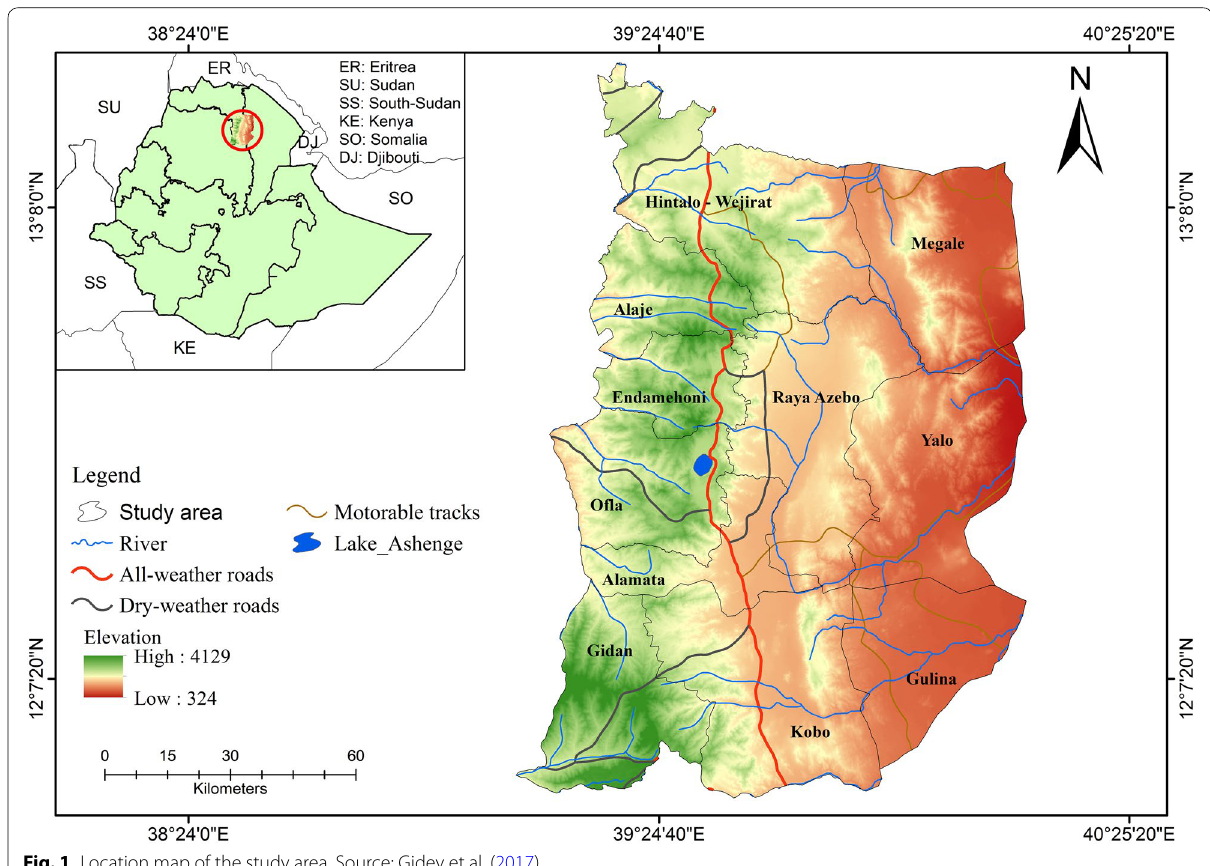
Fig. 1 Location map of the study area. Source: Gidey et al.